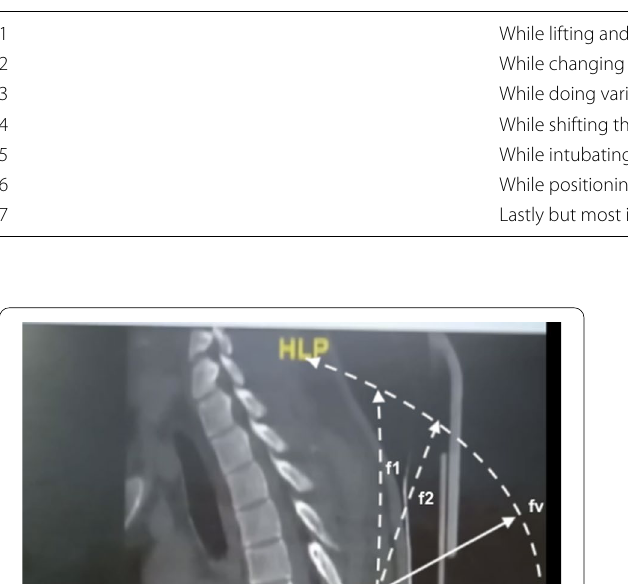
Table 1 Signifies the prevention to be taken before the patient is finally taken up for surgery if impaling agent is in situ or present as retained foreign body